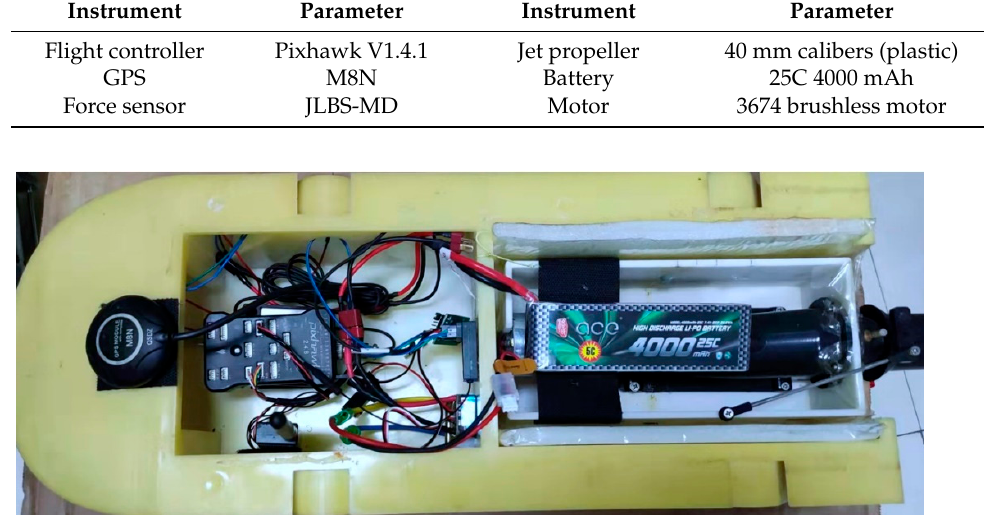
Figure 19. Picture of the experiment structure.